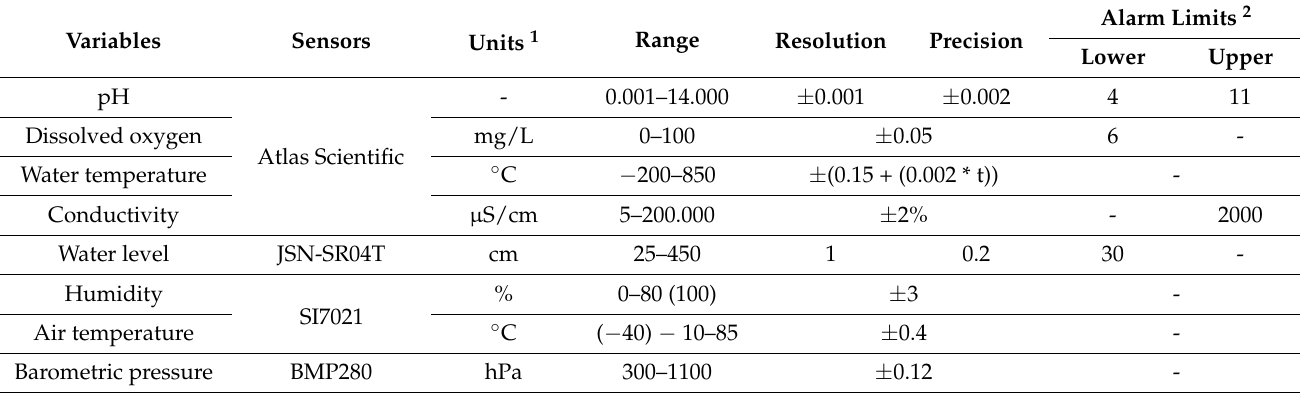
Figure 3. Final design of the node: ( a ) Node installed in the diversion channel of the facility; ( b ) Final electronic configuration.